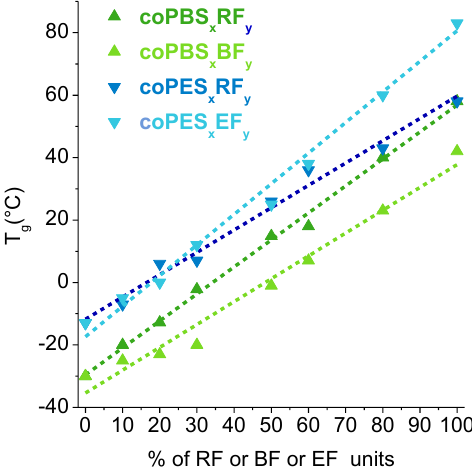
Figure 10. T g of furanoate-succinate copolyesters as a function of composition. Data reported by Morales-Huerta et al. [14] for co PBS x BF y and Terzoupolou et al. [15] for co PES x EF y are included for comparison.